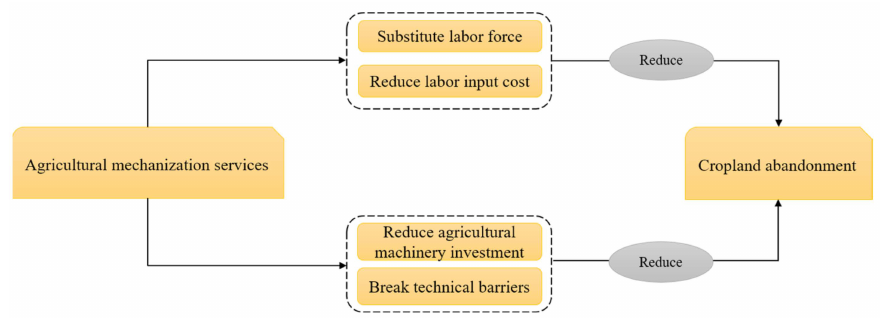
Figure 1. The figure of theoretical